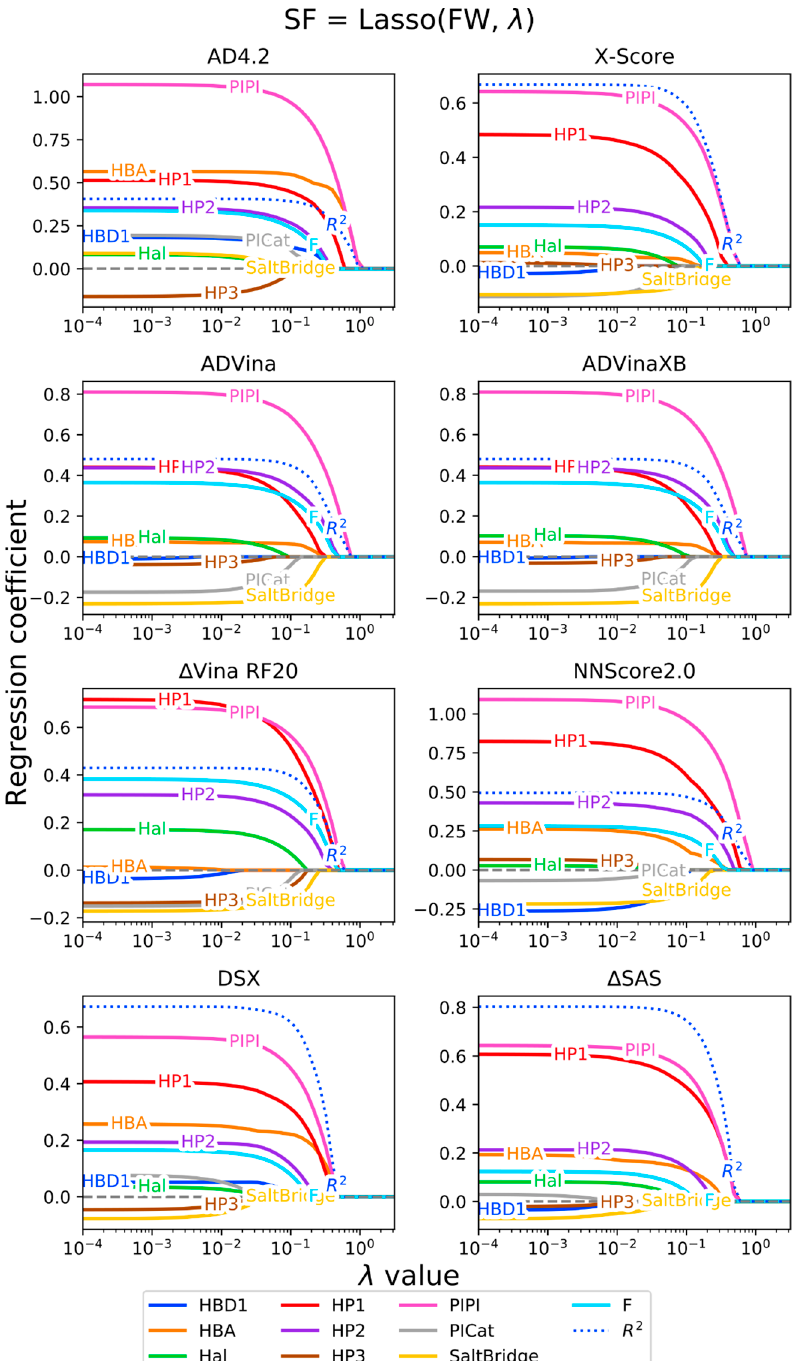
Figure 2. Statistical performance ( R 2 ) and the values of the coefficients of the Lasso model, relating the activity, predicted by scoring functions, and the presence of chemical features responsible for basic interactions. Increasing the magnitude of the regularization parameter, λ , results in that the non-zero coefficients remain only for the most statistically significant features .